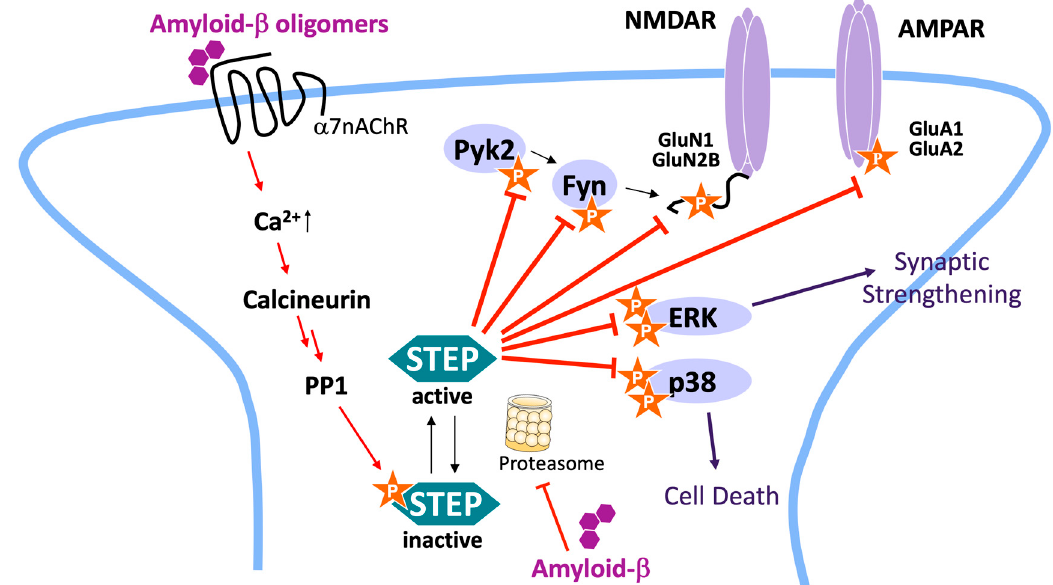
Figure 2. STEP signaling pathways and activation in AD. Amyloid- β (A β ) oligomers bind to and stimulate α 7 nicotinic receptors, leading to Ca 2+ influx, activation of calcineurin, and dephosphorylation (activation) of STEP by PP1. A β oligomers also elevate STEP levels through inhibition of the ubiquitin proteasome system. The net effect is an increase of active STEP. STEP dephosphorylates regulatory Tyr residues in the GluN2B (NR2B) and GluA2 receptor subunits, resulting in internalization of both NMDA and AMPA receptors. STEP also inactivates Fyn, the kinase that phosphorylates GluN2B, directly by dephosphorylation, and indirectly by inactivation of Pyk2, the kinase that activates Fyn. Finally, STEP inactivates MAP kinases ERK and p38, thereby opposing synaptic strengthening and cell death signaling pathways.